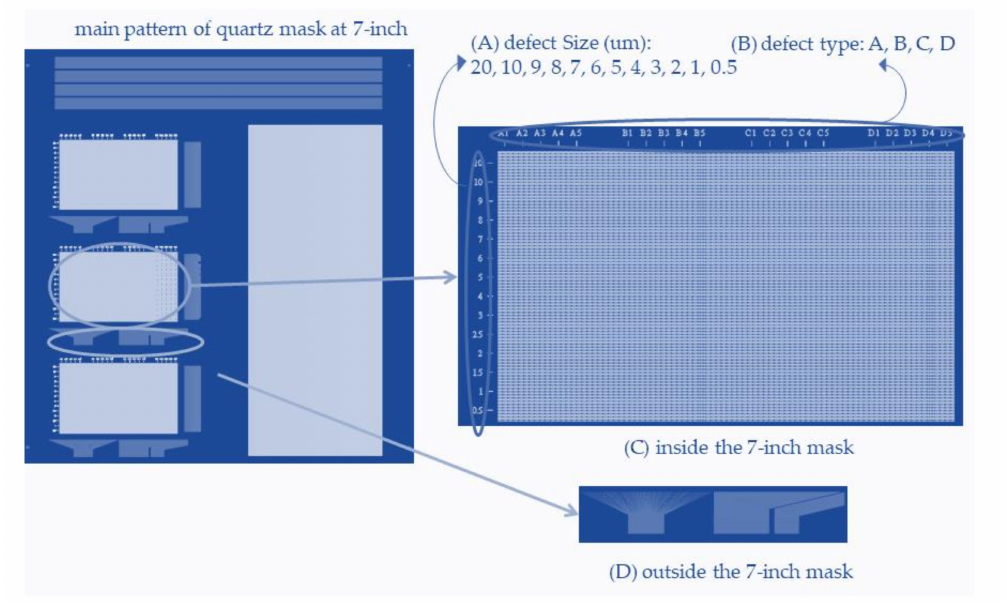
Figure 6. The pattern at ( A – D ) of the 7-inch mask scheme for automatic optical inspection (AOI)